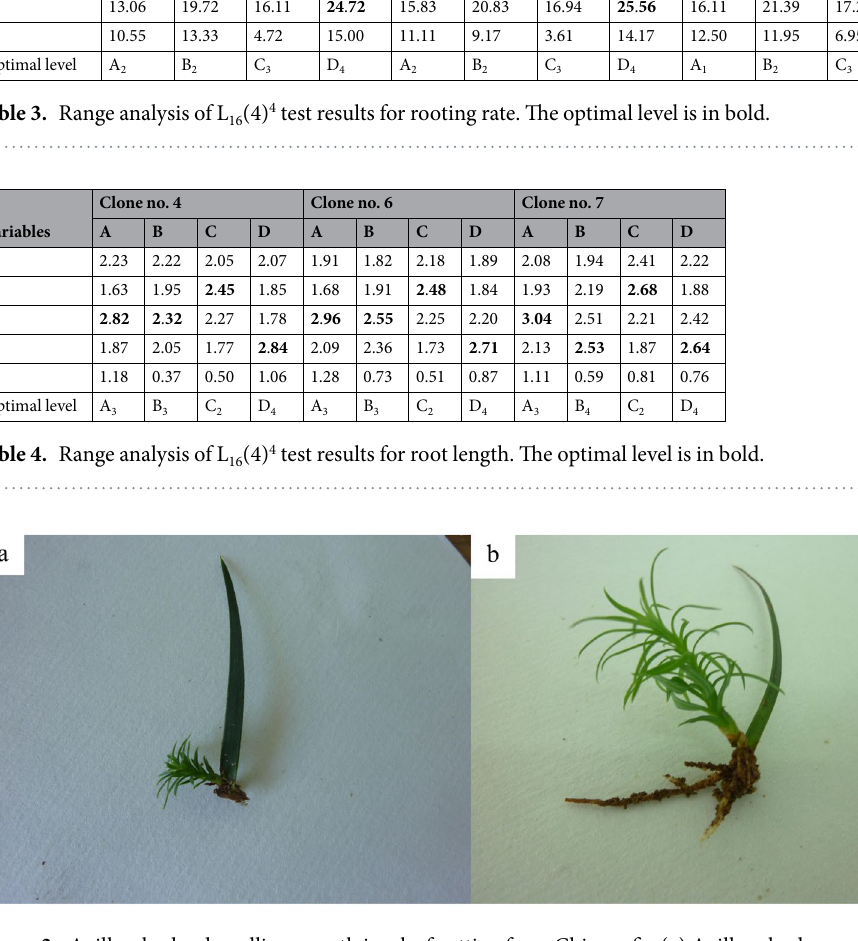
Figure 3. Axillarybudand seedling growth in a leaf cutting from Chinese fir. ( a ) Axillary bud appears 60 days after cutting; ( b ) plantlet development 90 days after